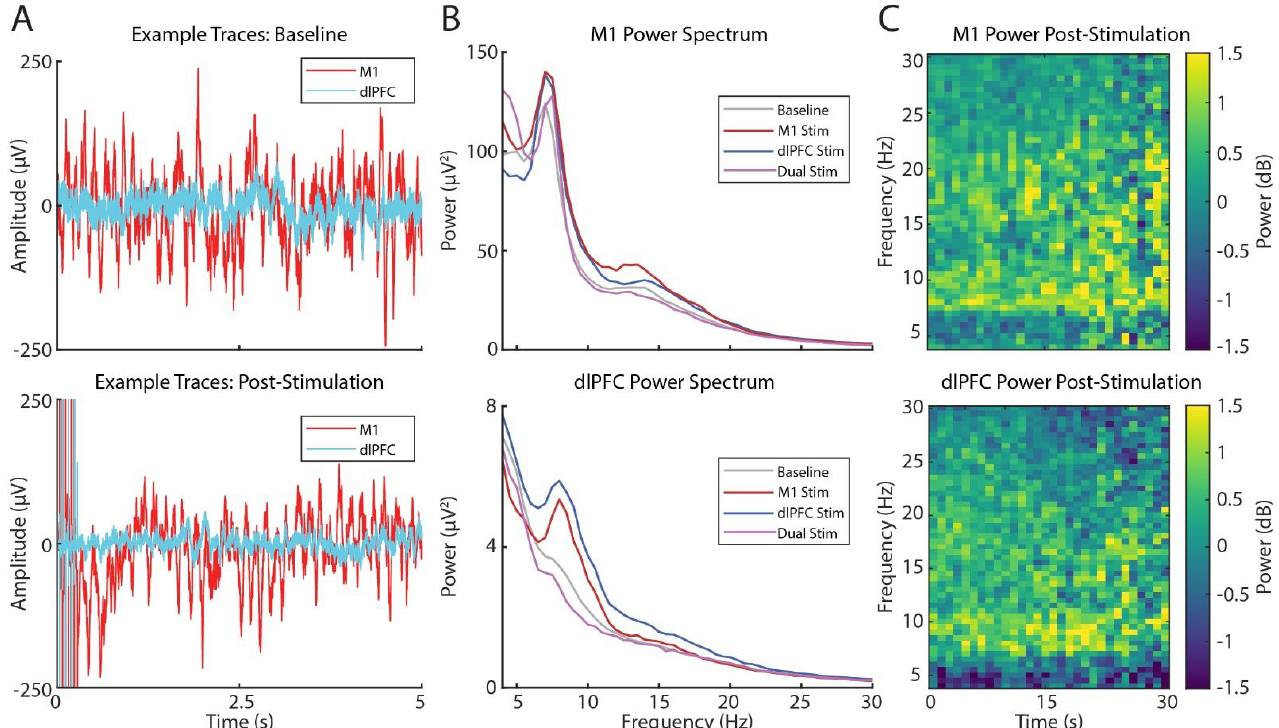
Figure 5. Effects of stimulation on M1 and dLPFC activity. ( A ) Voltage-time traces of M1 (red) and dlPFC activity (cyan) at baseline (top) and post-stimulation (bottom). ( B ) Power spectra at baseline and following M1 (maroon), dlPFC (dark blue), or dual-site stimulation (purple) in M1 (top) and dlPFC (bottom). ( C ) Spectrograms of M1 (top) and dlPFC (bottom) power post-stimulation normalized to the baseline period. Table 1. GLME results showing effect of stimulation on theta- (6 – 9 Hz) and low beta-band (13 – 20 Hz) power.